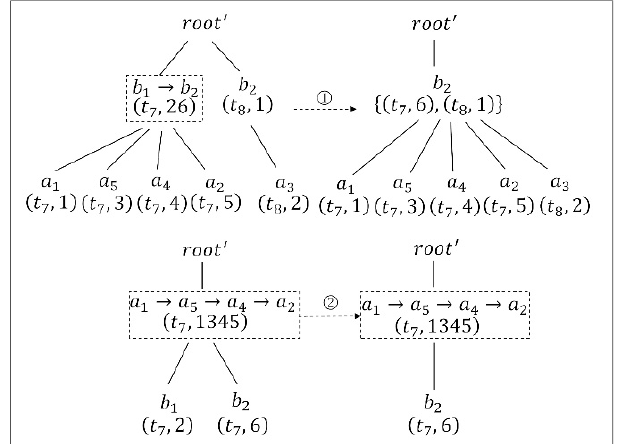
Figure 4. Updating of the TP-tree by using suppression. The number ① represents the location 𝑏 (cid:2869) was removed from 2 (cid:3041)(cid:3031) -level node 𝑏 (cid:2869) → 𝑏 (cid:2870) , and updated the remaining nodes, and ② represents 3 (cid:3041)(cid:3031) -level node 𝑏 (cid:2869) and also be